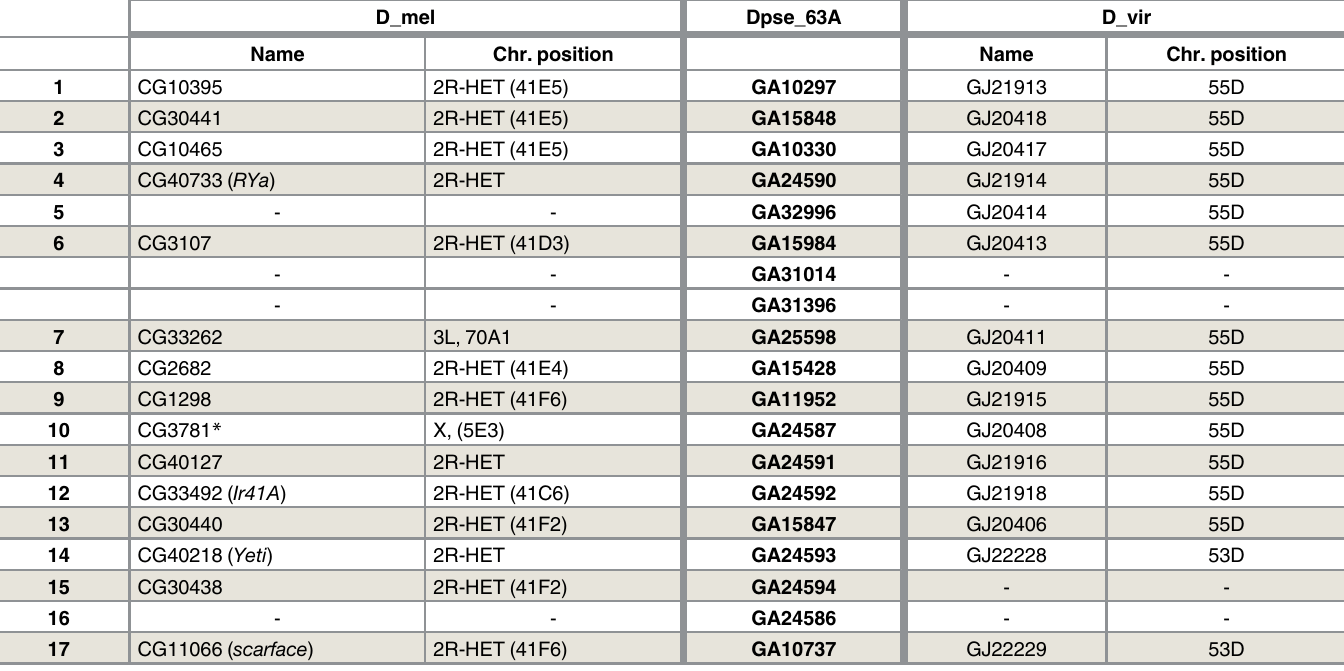
Table 3. List of D . pseudoobscura genes at Dpse_63A orthologous to genes of D . virilis and D . melanogaster .